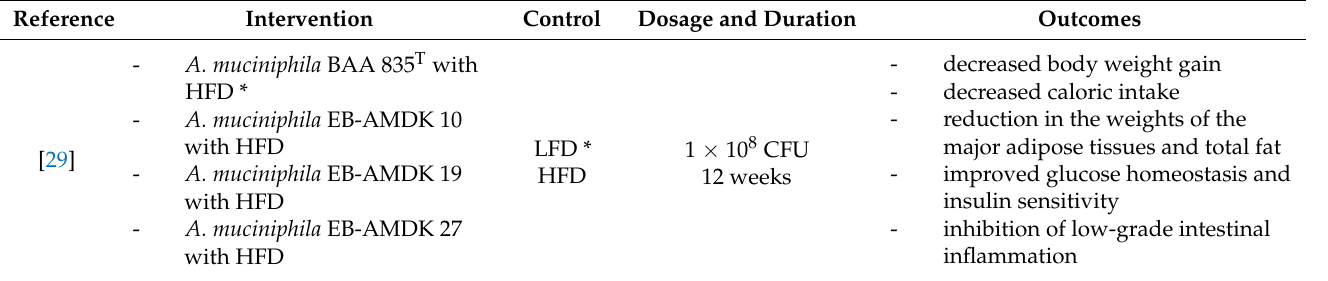
Table 2. Effects of Akkermansia muciniphila supplementation on obesity and metabolic parameters of male C57BL/6 mice.